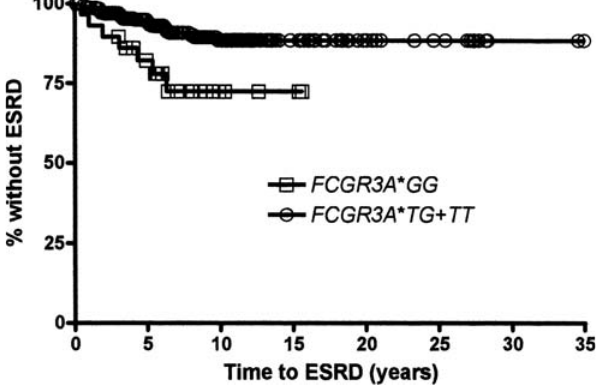
Figure 2. Kaplan-Meier Survival Curve for the Development of ESRD in Patients with FCGR3A*GG and FCGR3A*TT/GT DOI: